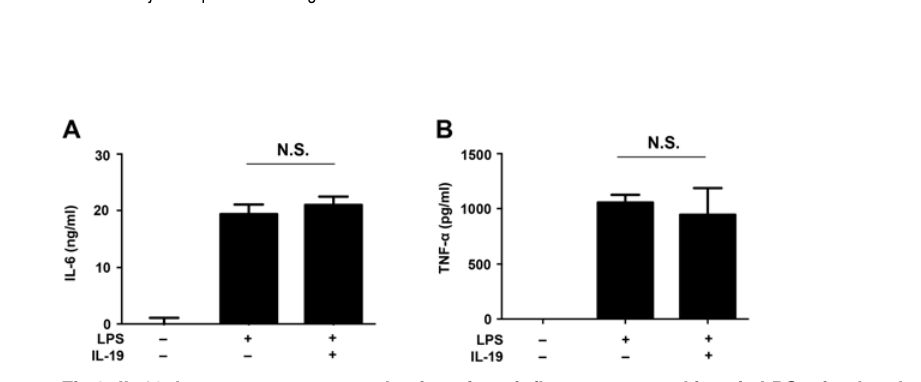
Fig 3. IL-19 does not suppress production of pro-inflammatory cytokines in LPS-stimulated astrocytes. Astrocytes were treated with LPS (100 ng/ml) and recombinant IL-19 (100 ng/ml) for 24 h. (A) Production of IL-6 and (B) TNF- α . Treatment with IL-19 did not microglial production of IL-6 and TNF- α . Values are means ± SD (n = 3). N.S., not significant.